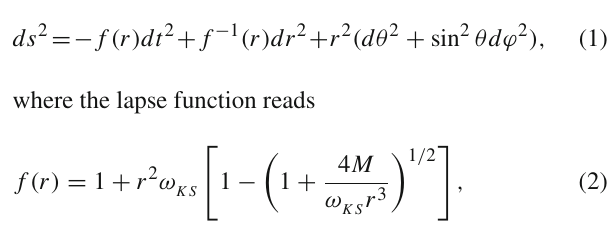
where m is the mass of the test particle ( m = 0 in the case we are dealing with, i.e. for photons), E is the energy of the particle (photon), L is the axial angular momentum of the particle (photon), S r ( r ) is a function of r and S θ (θ) is a function of θ